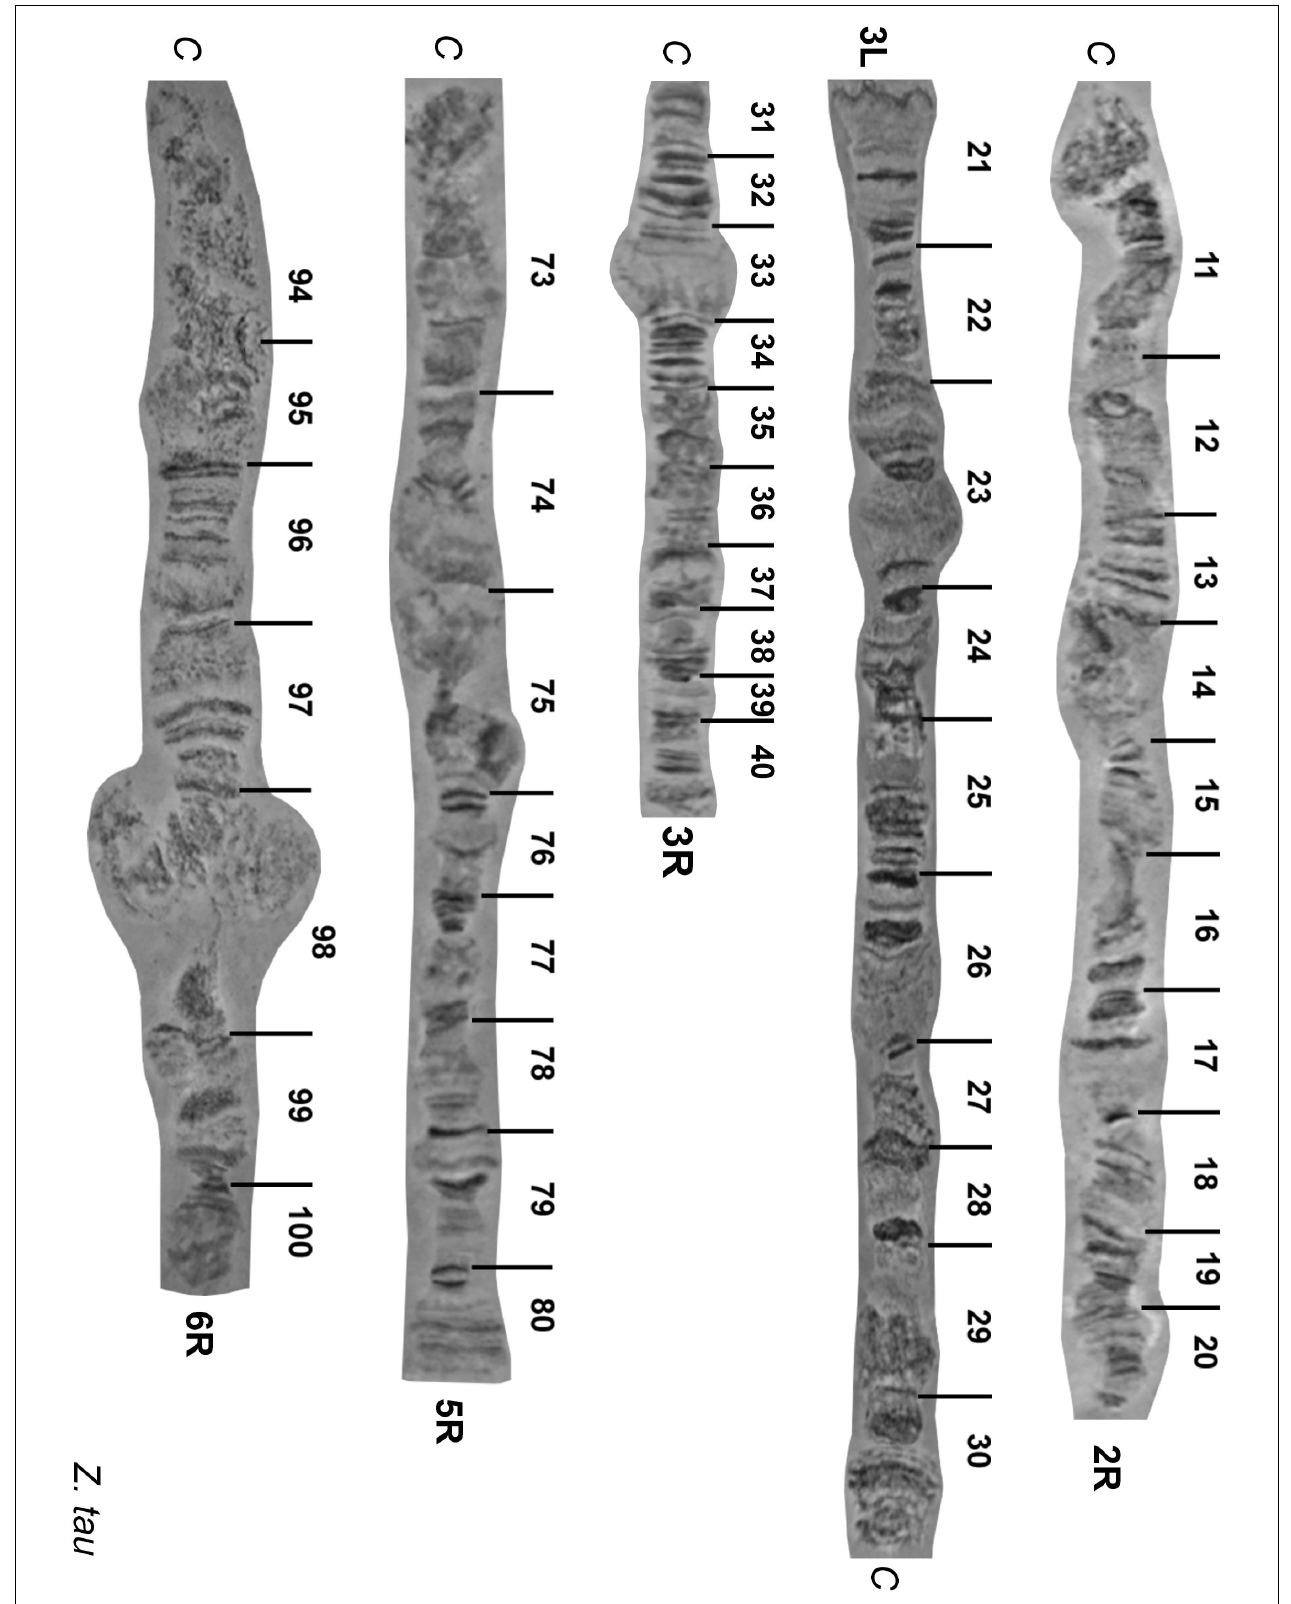
FIGURE 3 | Reference maps of Zeugodacus tau polytene chromosome arms 2R, 3L,3R 5R, 6R. Numbered divisions are shown, separated by lines. C: centromere.